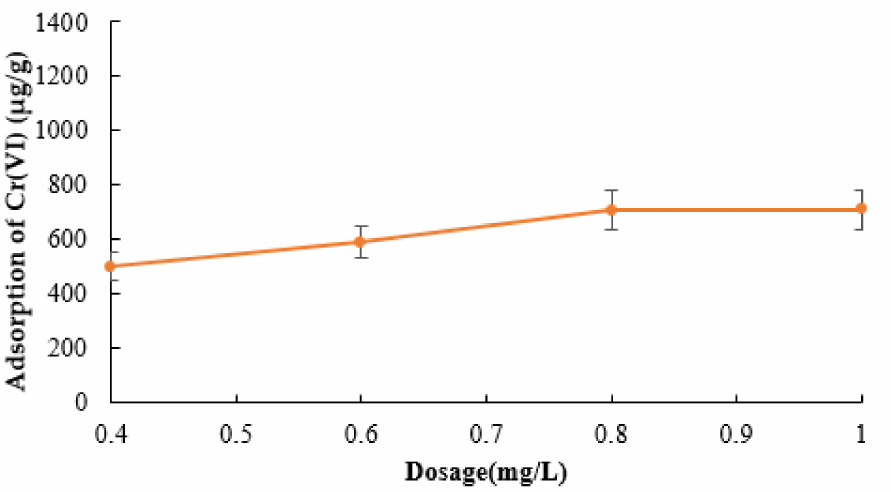
Figure 6. E ff ect of the adsorbent dosage on the adsorption of Cr(VI) on the SDS-modified chitosan